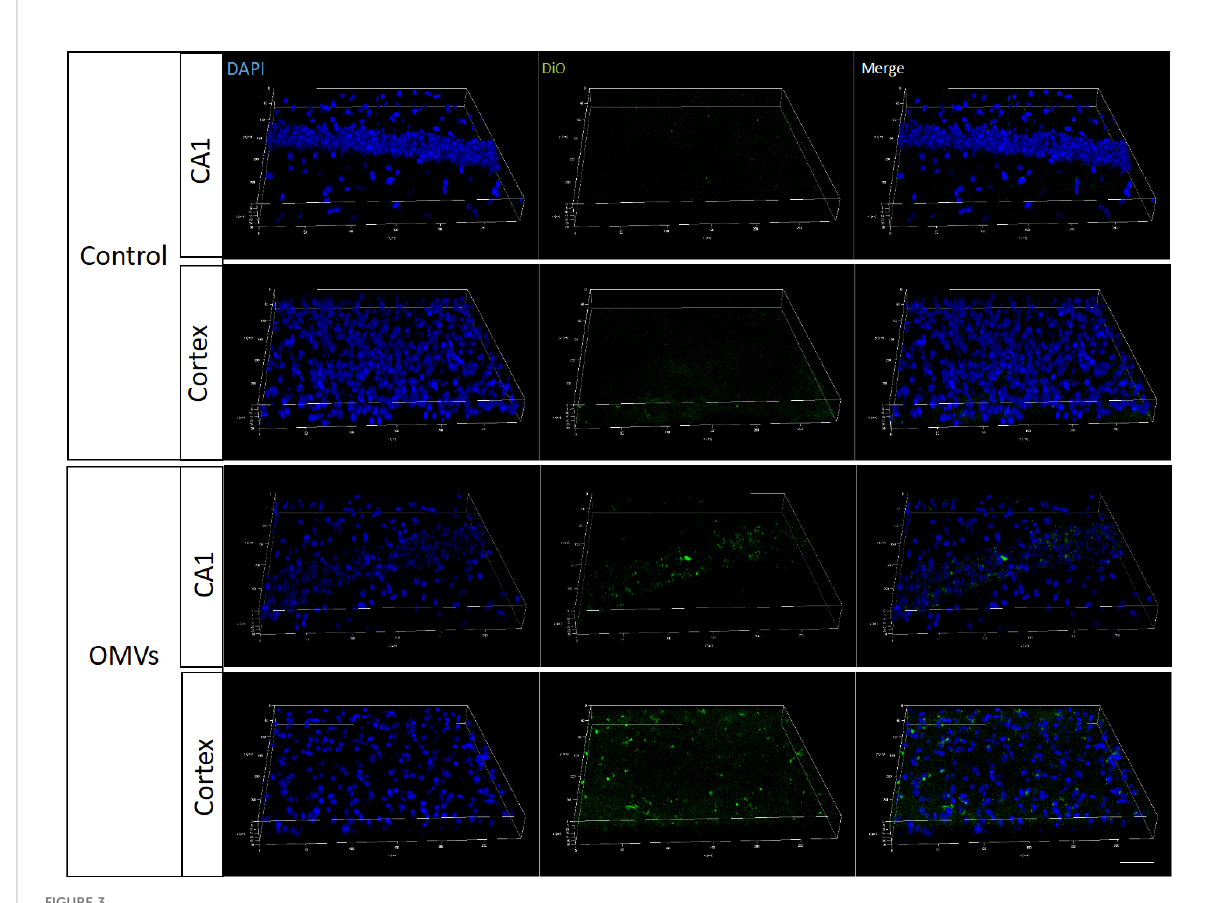
FIGURE 3 Pg OMVs enter the brain. Pg OMVs labeled with DiO (green) were applied by oral gavage for three days and were detected by confocal microscopy in the hippocampus and cortex of mice. Scale bar = 50 m